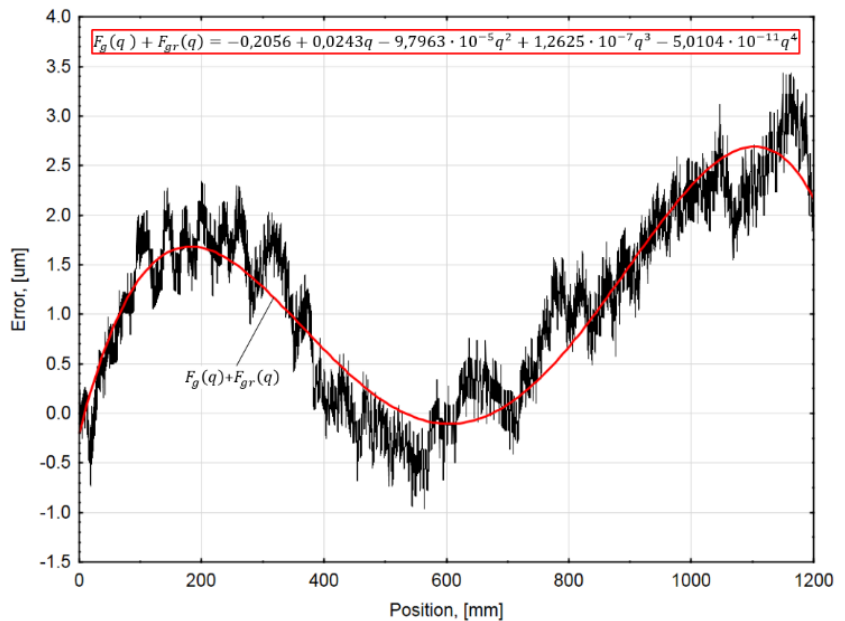
Figure 5. Average accuracy graph at 20 °C ambient temperature approximated by a parametric function. (Red line—approximating function and its equation).